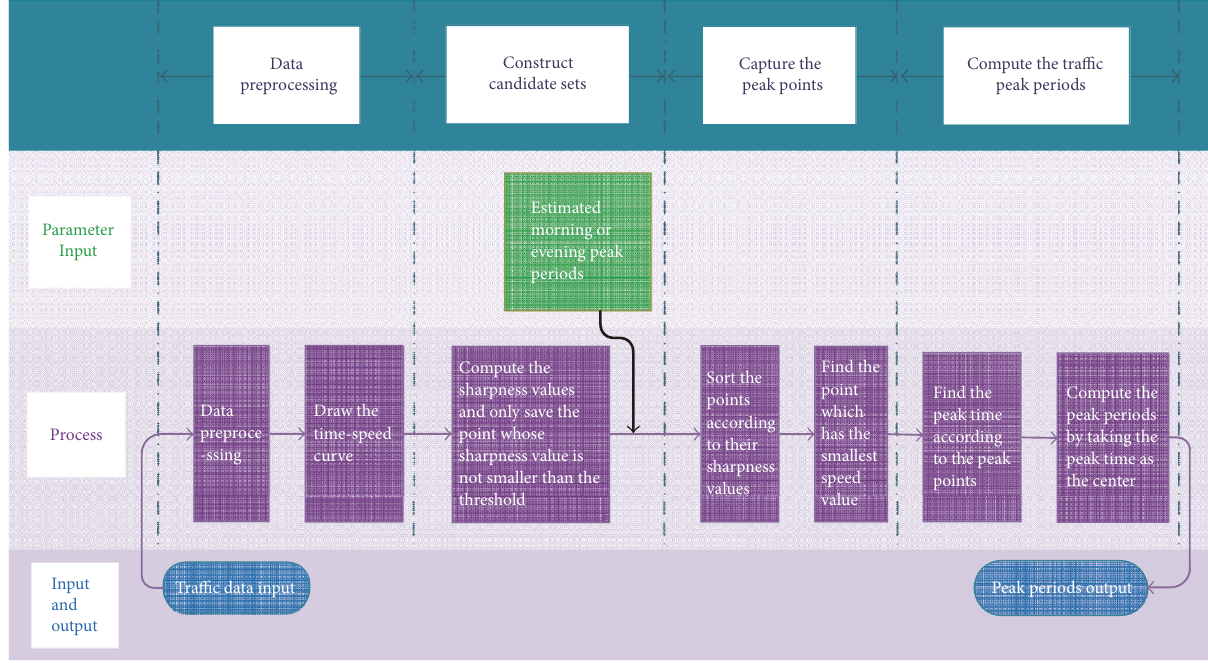
Figure 4: The framework of the proposed